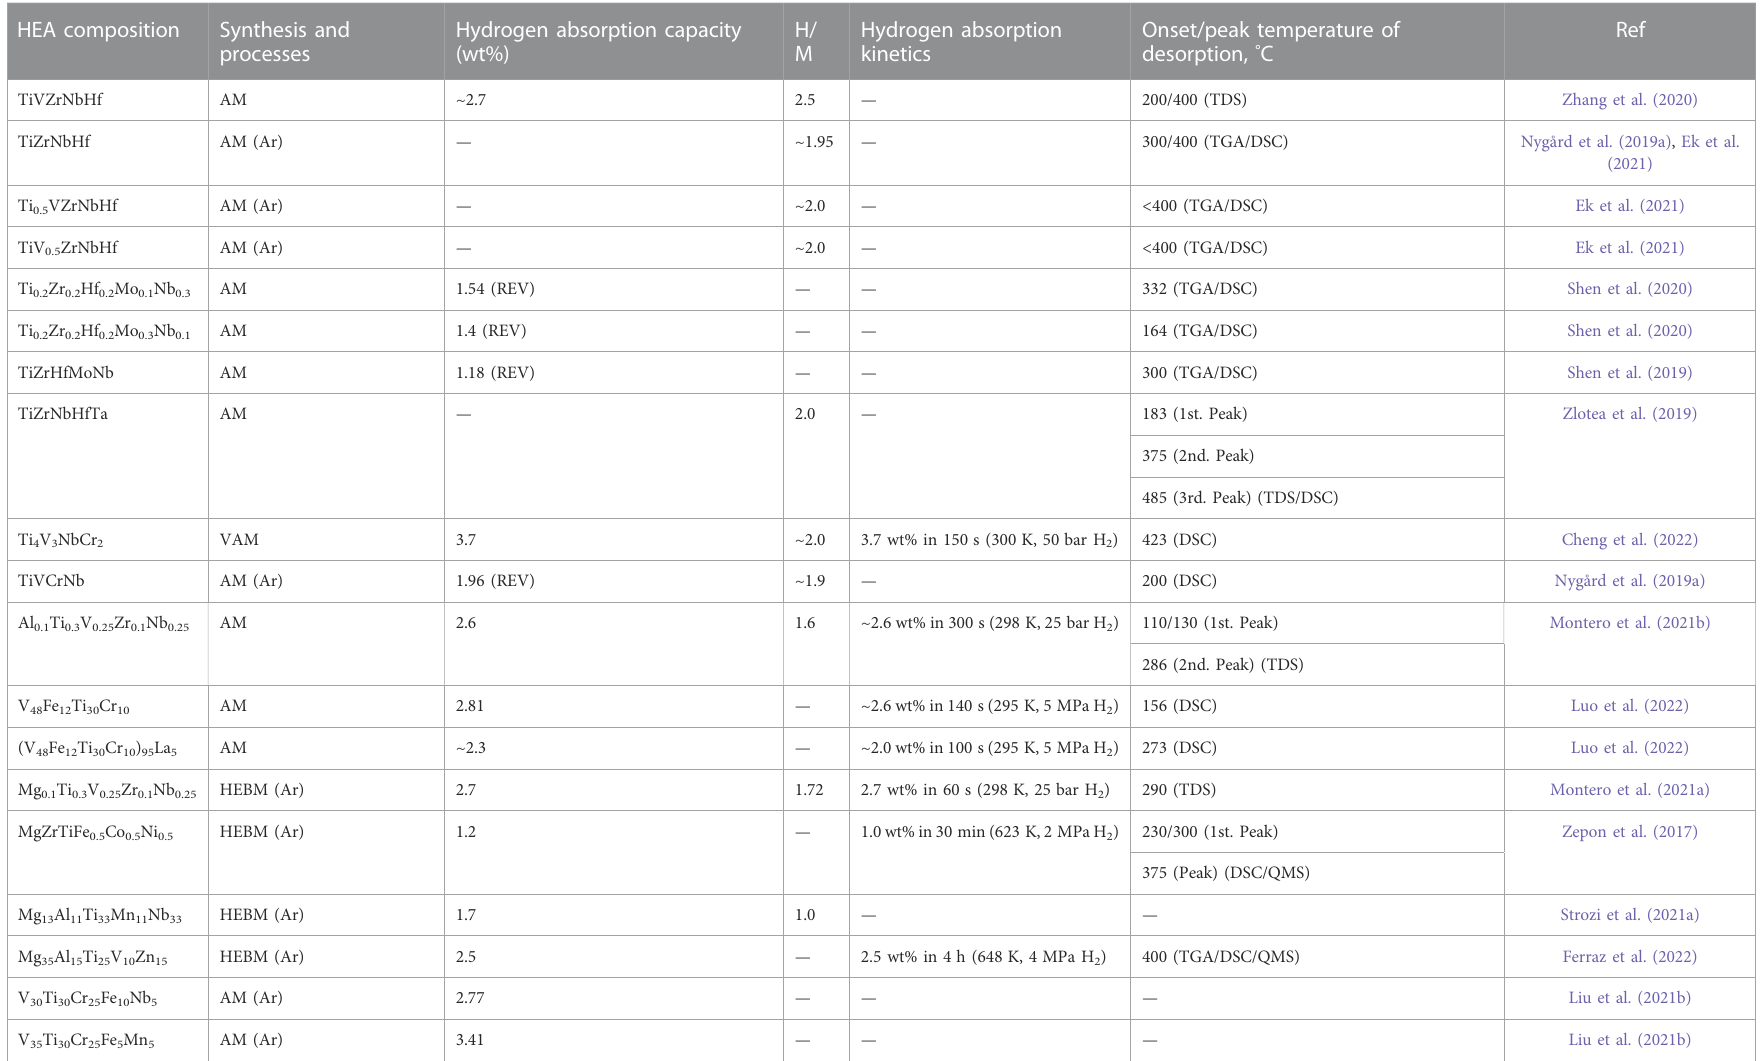
TABLE 1 Reported BCC-structured HEAs ’ hydrogen storage performance.